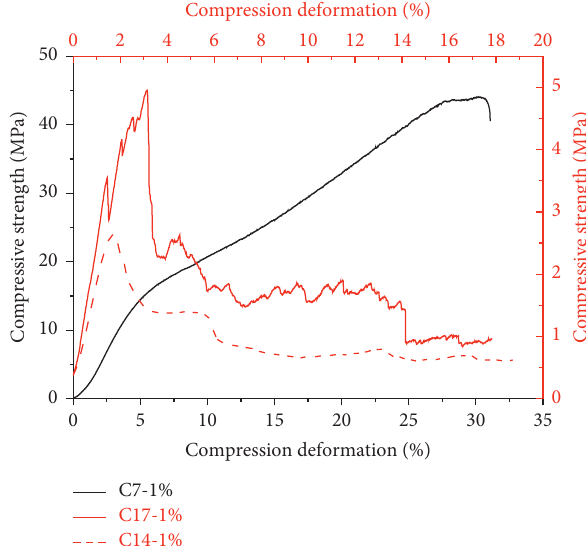
Figure 14: The compressive strength curves of the three